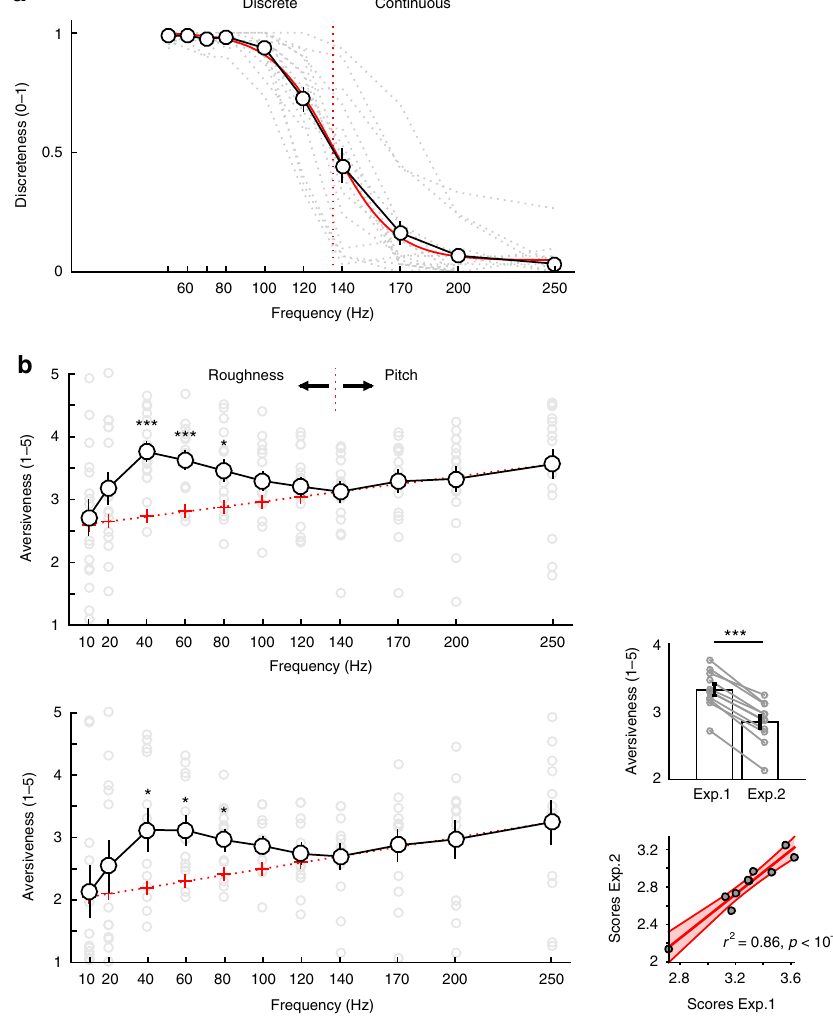
Fig. 1 Temporal perceptual transition and subjective assessment of temporal salience. a Temporal discretisation limit experiment (Experiment 1). Averaged subjective reports of discreteness (1 – discrete, 0 – continuous) averaged across participants indicate that subjective percept switches from discrete to continuous around 130 Hz (red dotted line: 50% discreteness ratings), which roughly corresponds to the upper limit of the roughness acoustic attribute. The continuous red curve represents the sigmoidal fi t to the average across participants. Dotted light grey lines correspond to individual data. b Temporal salience experiments. Top panel: Experiment 2a. Averaged subjective aversion (reported on a 1 – 5 scale) follows a nonlinear pattern. Above the discretisation limit (>130 Hz, i.e., in the pitch range), aversion is linearly proportional to the frequency (energy) of the stimulus. Below this limit, in the roughness range, subjective aversion follows a nonlinear pro fi le and is maximal at 40 Hz. Divergence from linearity in the roughness range is measured as the difference with aversion values predicted by a linear extrapolation of averaged aversion values measured above the discretisation limit. Light grey circles correspond to individual data Bottom panel: Experiment 2b: independent replication of Experiment 2a using the same stimuli at lower intensity (50 dB SPL) in n = 12 additional participants. Upper right inset: Main effect of sound intensity between Experiments 2a and 2b. Grey data points correspond to stimuli frequencies. Lower right inset: correlation plot between averaged ratings at each frequency in Experiment 2a and 2b. Error bars indicate SEM. ** and *** indicate signi fi cant p -values at 0.01 and 0.001, FDR